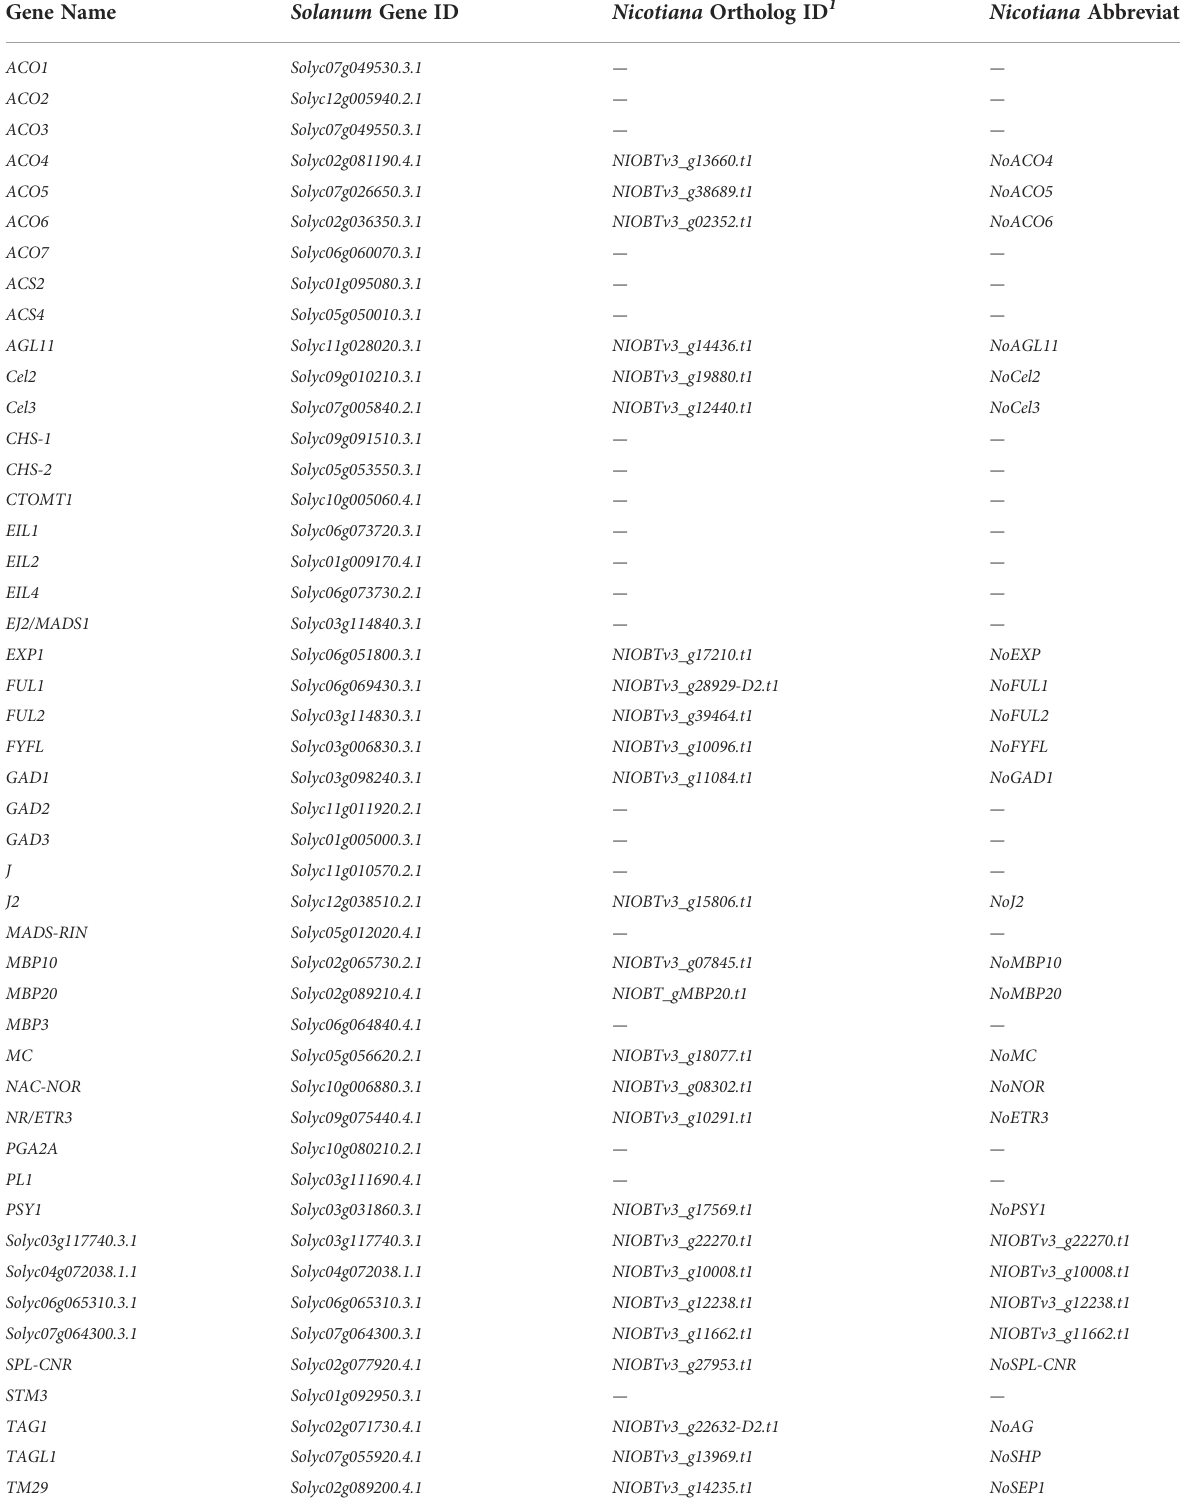
TABLE 2 Table showing the relationships between orthologous genes identi fi ed in this study. Orthology and